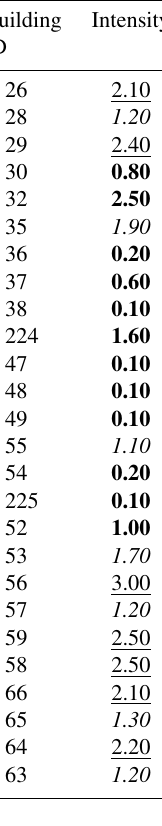
Table 2. Comparison of the results per building. The typeface indicates the degree of intensity as described in Table 1 (bold for inten- sity < 1m, italic for intensities 1–2m and underlined for intensities >